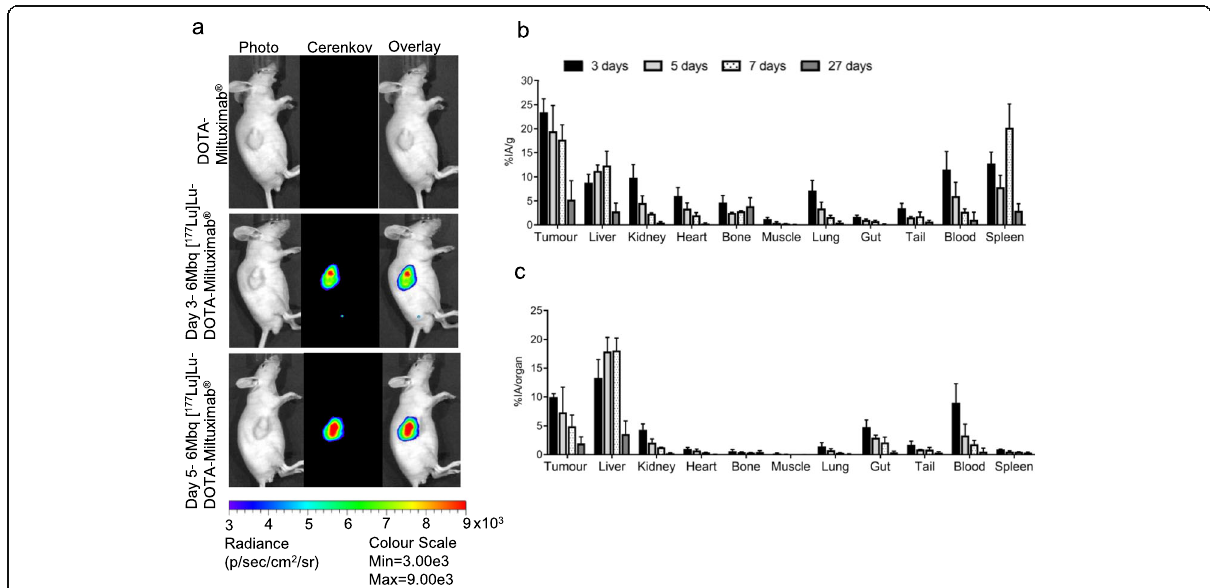
Fig. 2 Uptake of [ 177 Lu]Lu-DOTA-Miltuximab® in tumour-bearing BALB/c/nude mice. a Imaging of Cerenkov radiation from representative mice bearing DU-145-RFP-Luc xenografts on days 3 and 5 post intravenous injection of 6 MBq [ 177 Lu]Lu-DOTA-Miltuximab®. b , c Biodistribution in %injected activity (IA)/gram and %IA/organ, respectively, of [ 177 Lu]Lu-DOTA-Miltuximab® in tumour-bearing BALB/c/nude mice on day 3 ( n = 3), day 5 ( n = 2), day 7 ( n = 2) and day 27 endpoint ( n = 6) post injection of a 6 MBq dose, assessed by gamma counting of organs ex vivo. Shown are mean with